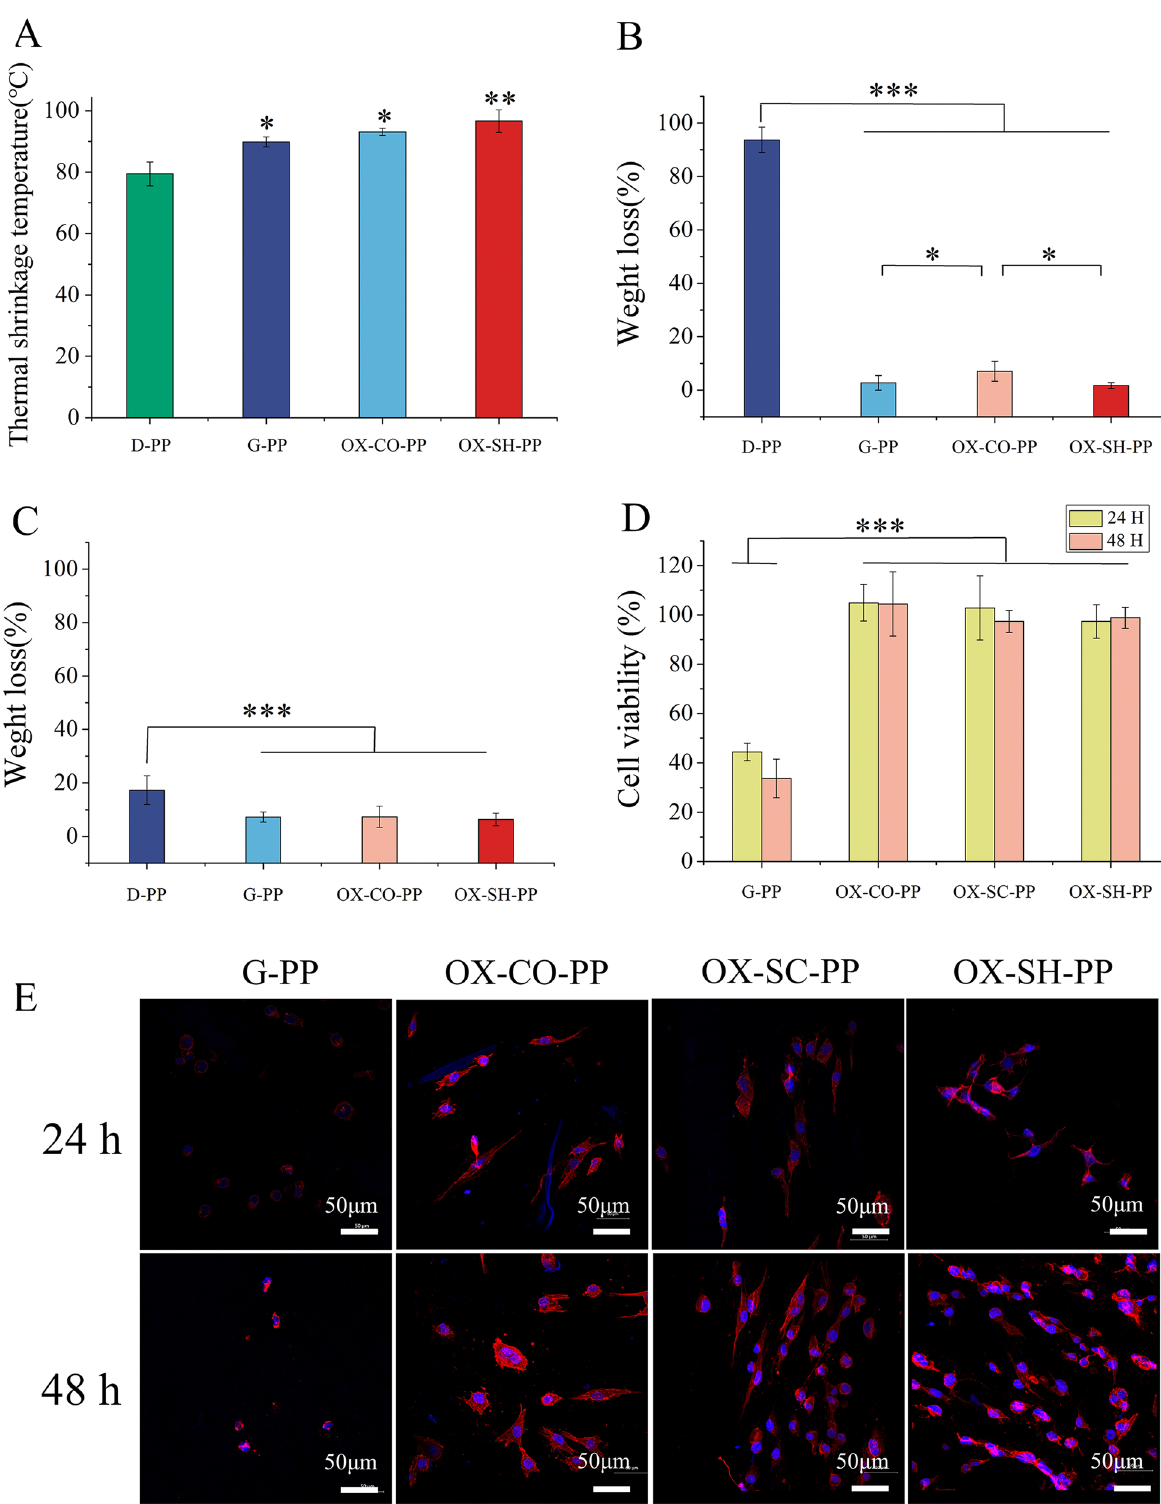
Fig. 2 A The thermal shrinkage temperature of D-PP or crosslinking PP (n assessment after incubated with the extraction medium of PPs for 24 h or 48 h. E Observation of adhesion of HUVECs to the valves after 24 h and 48 h growth by TRITC-pholloidin (red) and DAPI (blue) staining. (bar